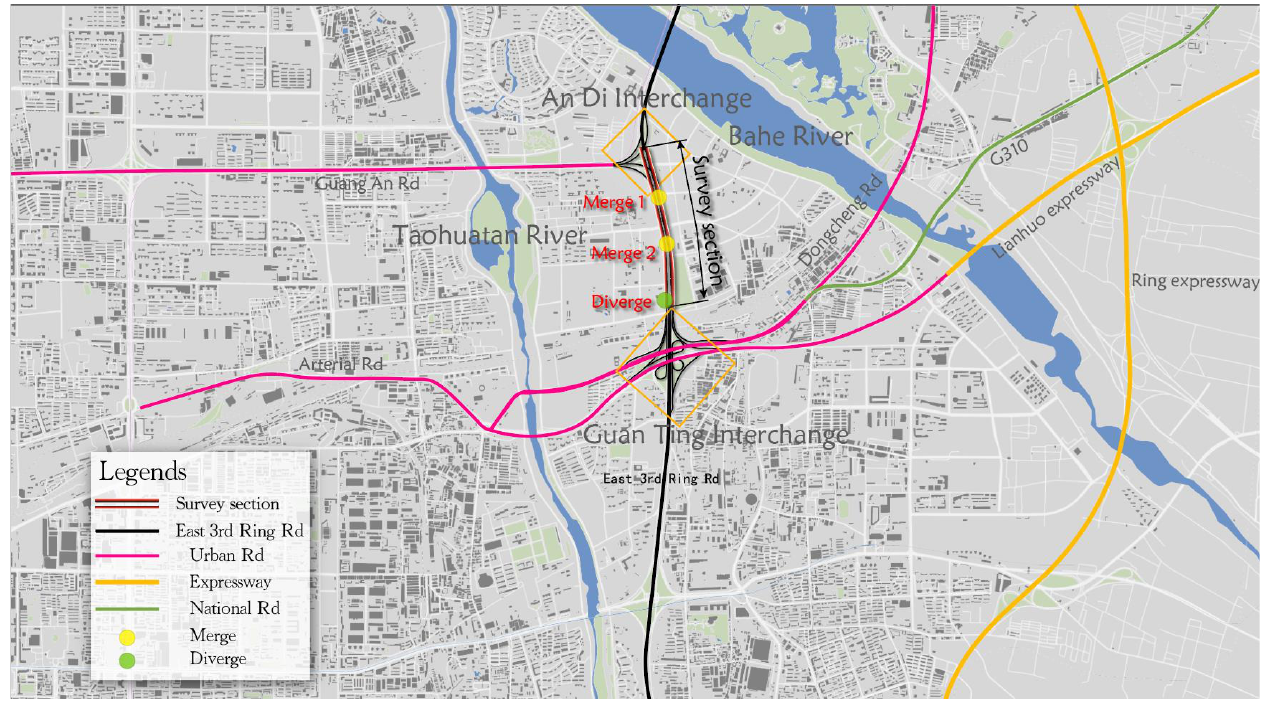
Figure 7. Survey site and objects.